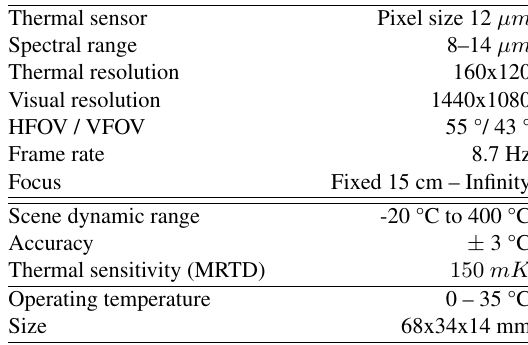
Table 1. FLIR ONE PRO camera specification